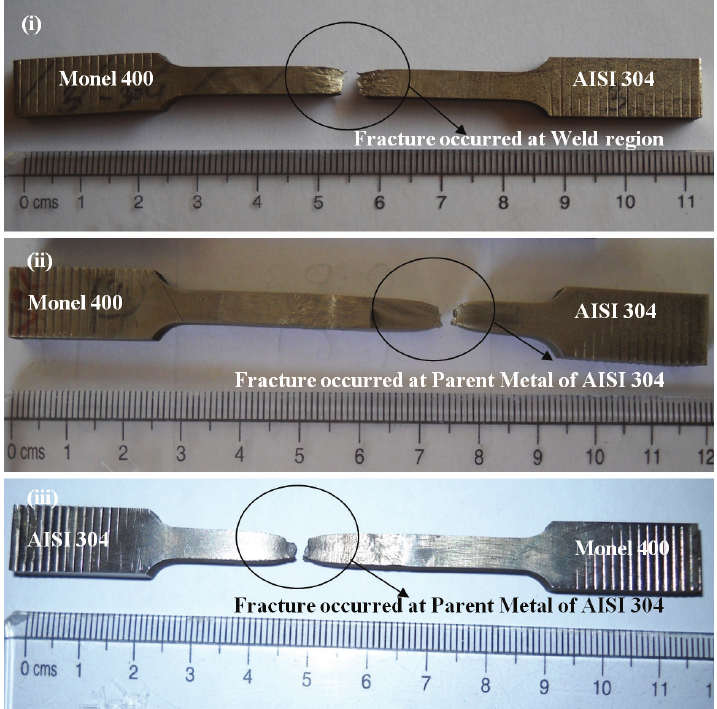
Figure 5. Fractured tensile samples of PCGTA welds of Monel 400 and AOSO 304 using (i) ER309L (ii) ERNiCu-7 and (iii) ERNiCrFe-3 filler wires.